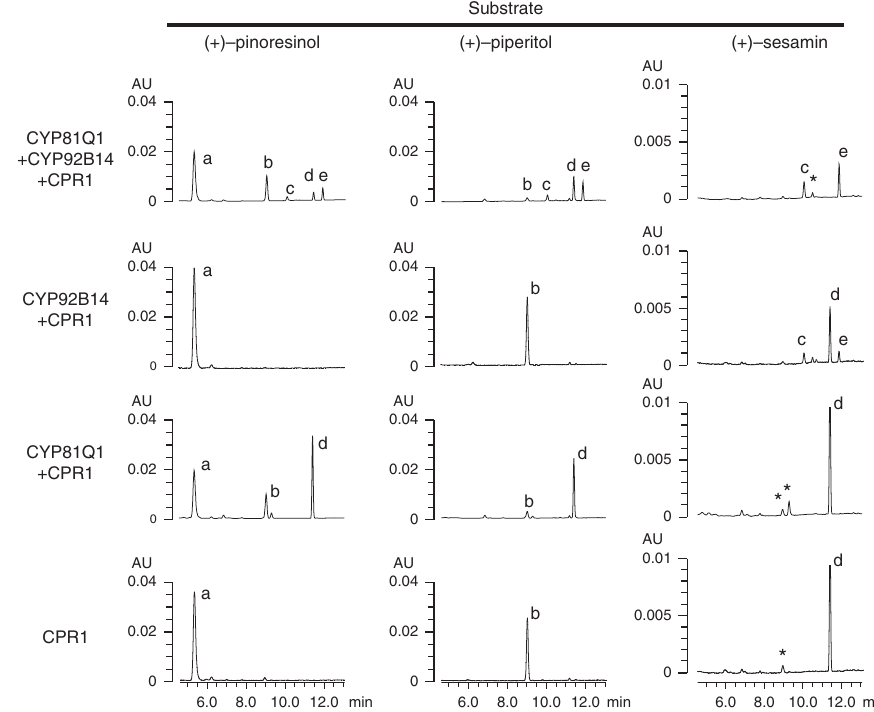
Fig. 4 Co-expression of CYP81Q1 ameliorates the activity of CYP92B14 to produce (+)-sesamolin and (+)-sesaminol from (+)-sesamin in yeast cells. Yeast cell lines expressing either or both CYP81Q1 and CYP92B14 together with CPR1 were subjected to bioassays using designated lignan as a substrate. Assay products after 48 h incubation were analyzed by HPLC at 283 nm. a: (+)-pinoresinol, b: (+)-piperitol, c: (+)-sesaminol, d: (+)-sesamin, e: (+)-sesamolin. Asterisks indicate unknown